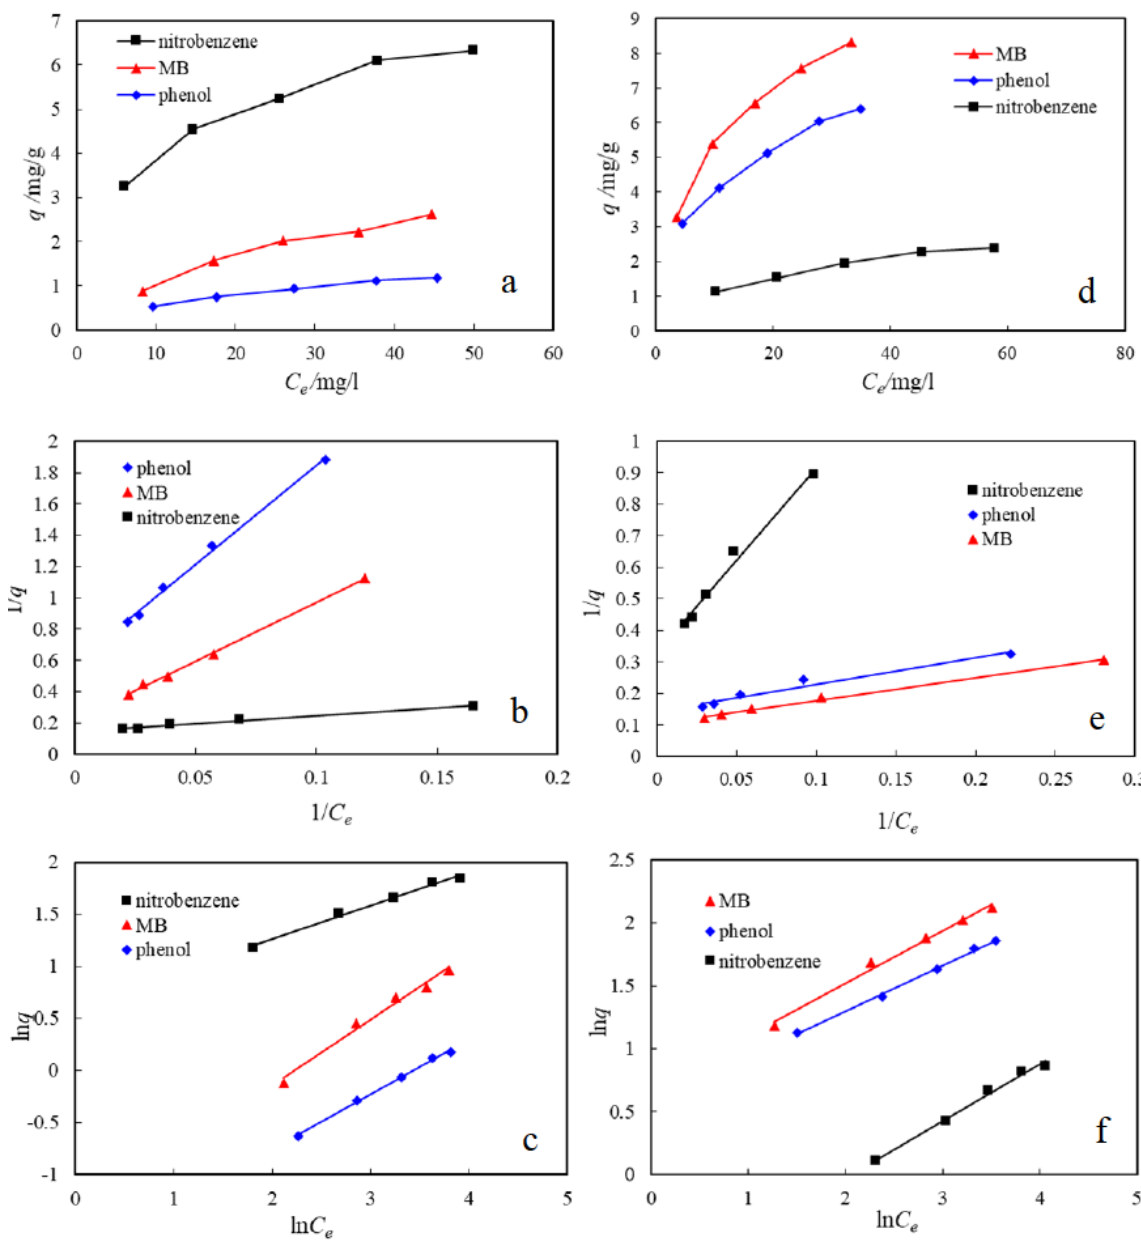
Figure 6: Adsorption isotherm and fitting curves of nitrobenzene, phenol and MB by SiO 2 (AG) (a), (b), (c) and (d), (e), (f): Adsorption isotherm, Langmuir fitting curves and Freundlich fitting curves of hydrophobic SiO 2 (AG) and hydrophilic SiO 2 (AG), respectively